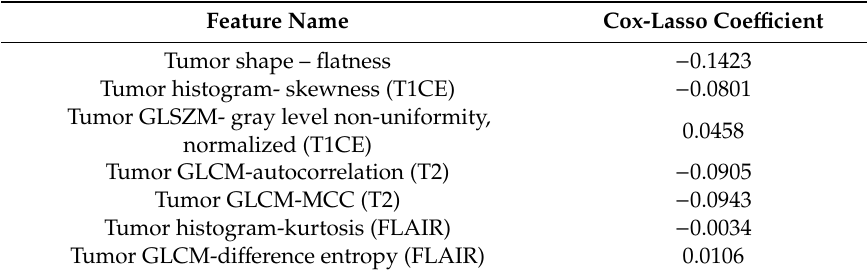
Table 1. Selected radiomics features associated with prognosis of glioblastoma patients.